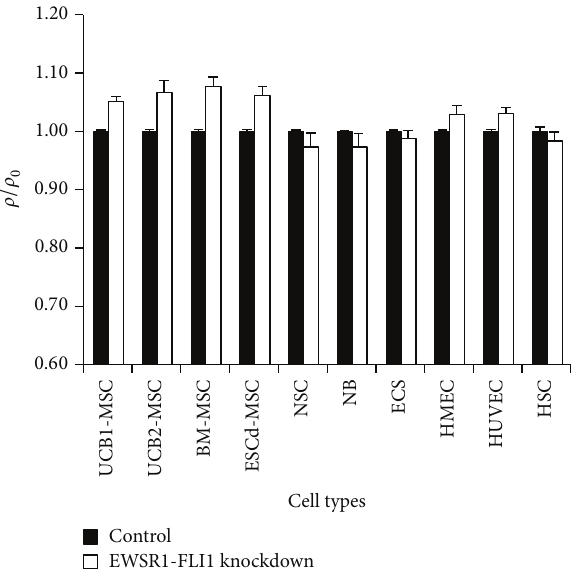
Figure 6: Relative Pearson correlation coefficients from the data from Figure 5. DNA microarray cel files were processed as described in the caption of Figure 5. Pearson correlation coefficients 𝜌 were calculated for samples from Ewing sarcoma cell lines from data set GSE7007 [3] and all stem cell samples. For each EFT sample, the mean of the Pearson correlation coefficients in the control samples without EWSR1-FLI1 inhibition 𝜌 0 was set as1. Presented aremeansand standard deviations forthecorrelations between theindicated cell typesand Ewing sarcoma cell lines after knockdown of EWSR1-FLI1 (EWS-FLI1 knockdown) or control cell lines (control) without EWSR1-FLI1